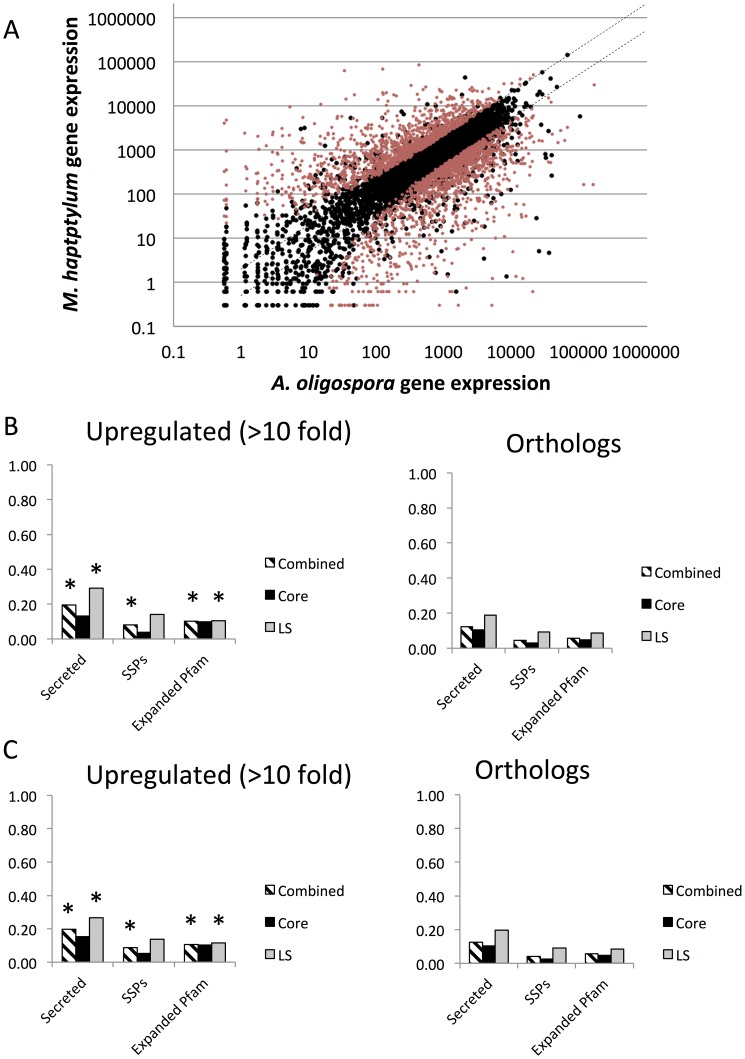
Comparison of gene expression in M. haptotylum and A. oligospora during infection of the nematode C. briggsae.(A) Log10 scatter plot of gene expression pattern between orthologs of M. haptotylum (mean of two replicates, 4 hours of infection) and A. oligospora (mean of samples from 6 and 10 hours of infection as replicates). The red circles indicate 2,599 significantly differentially expressed genes (q-value <0.01). (B) Features of M. haptotylum genes that are >10 fold upregulated in comparison with A. oligospora. (C) Features of A. oligospora genes that are >10 fold upregulated in comparison with M. haptotylum. “*” indicates the categories of genes that were significantly (P<0.001) enriched among the upregulated genes as compared with their distribution in the genome (right). “Combined” includes core + LS + SS.